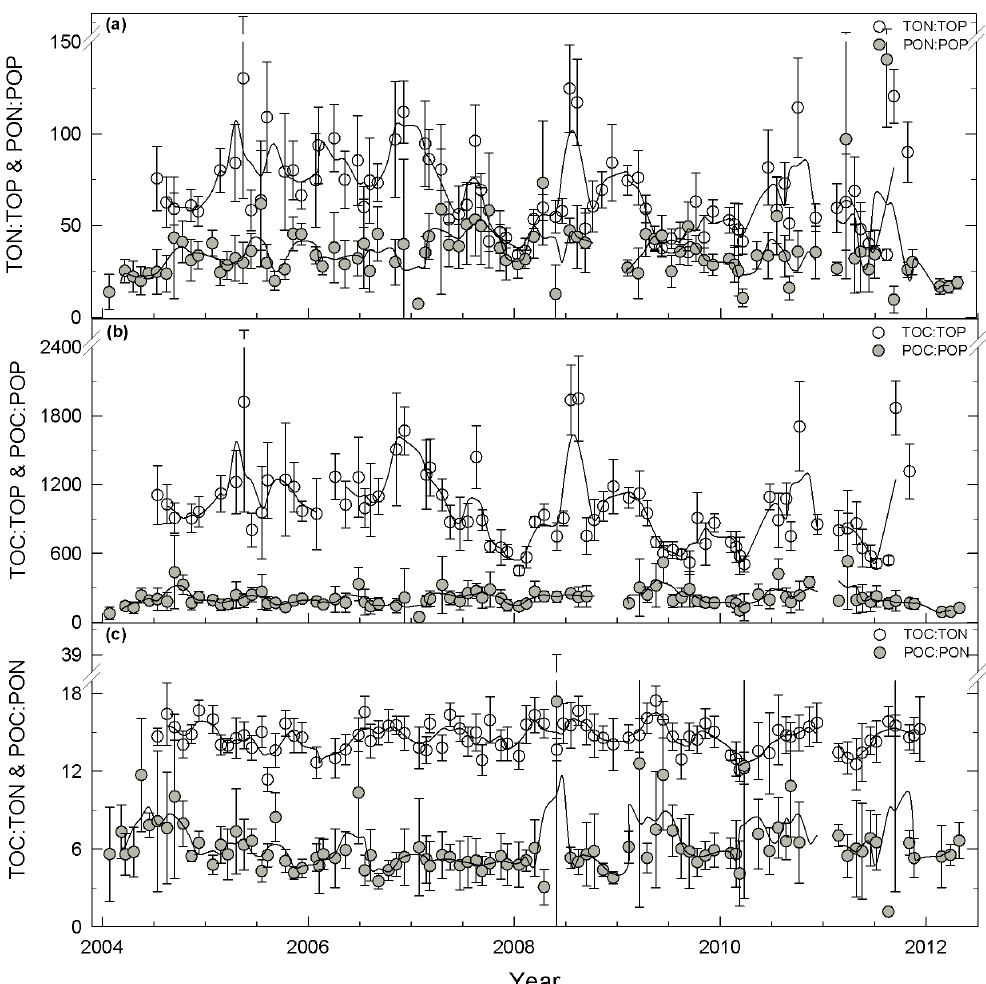
Figure 2. Monthly stoichiometry during 2004–2010 at 0–100m. Solid lines are 3-month running means. Error bars are 1 σ from the mean